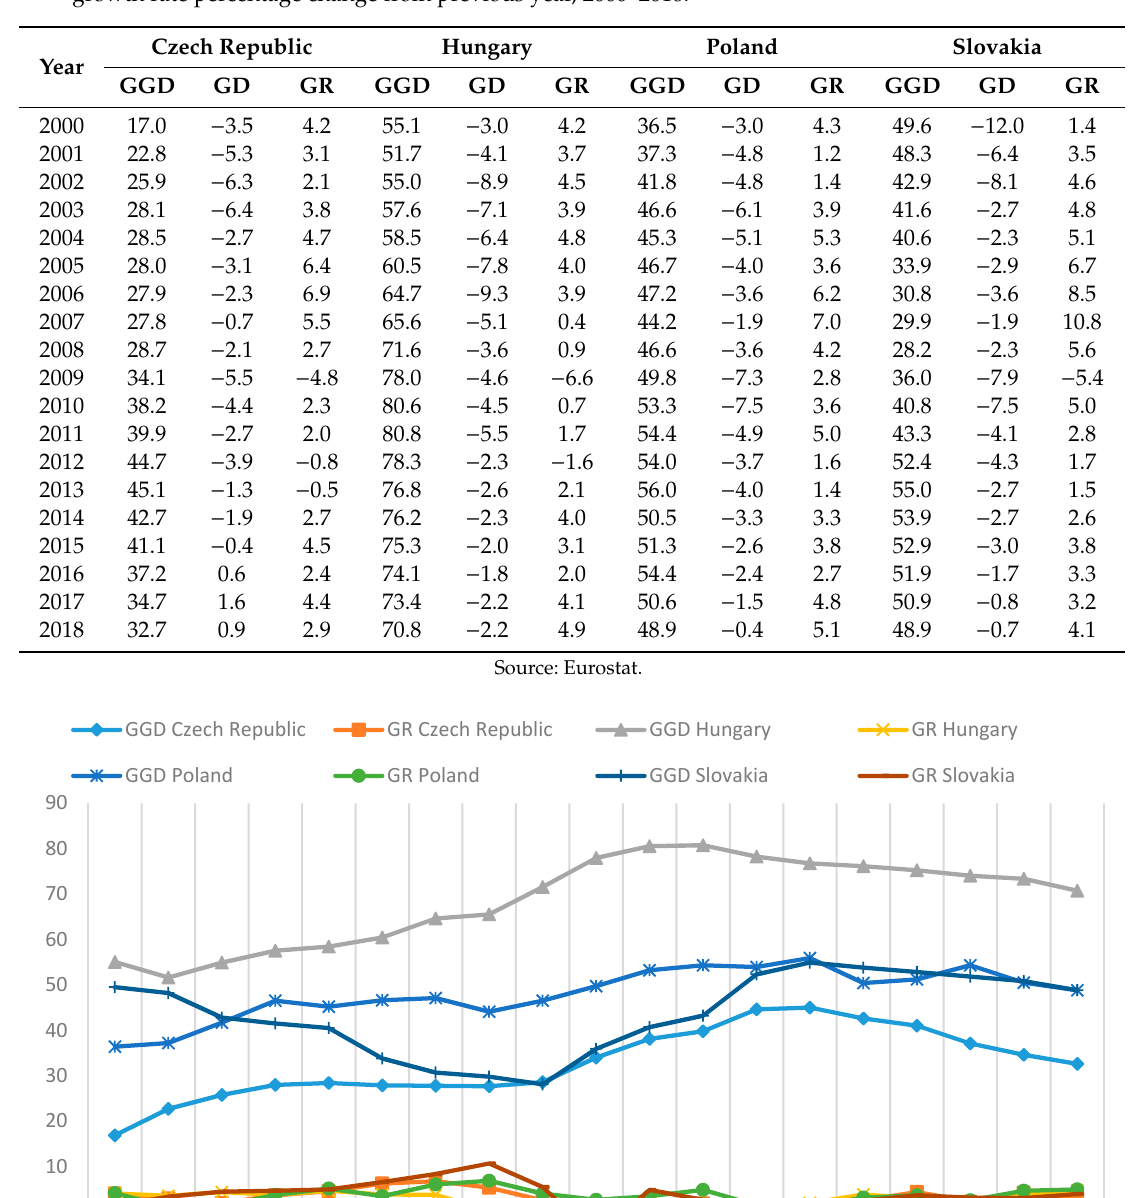
Figure 5. Central and Eastern European countries’ GD percentage of GDP versus growth rate percentage change from previous year, 2000–2018; Source: Eurostat. 4.3. The Balkan Countries Within the four EU Balkan countries, GGD and GD as a percentage of GDP illustrated some volatility over the nineteen-year study (Table 3). Bulgaria, from 2003 onward, and Romania, throughout the whole study period, demonstrated two of the lowest GGDs EU-wide, with very dynamic growth rates throughout 2002–2008. They both experienced low growth from the recession in 2009, in which Bulgaria rose to above 3% from 2015 onward while Romania did not (Figure 6).